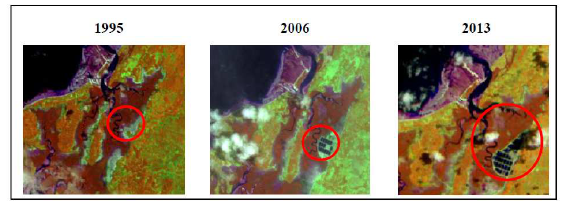
Figure 8 Mangrove clearance due to Shrimp Farming in Mafia Island